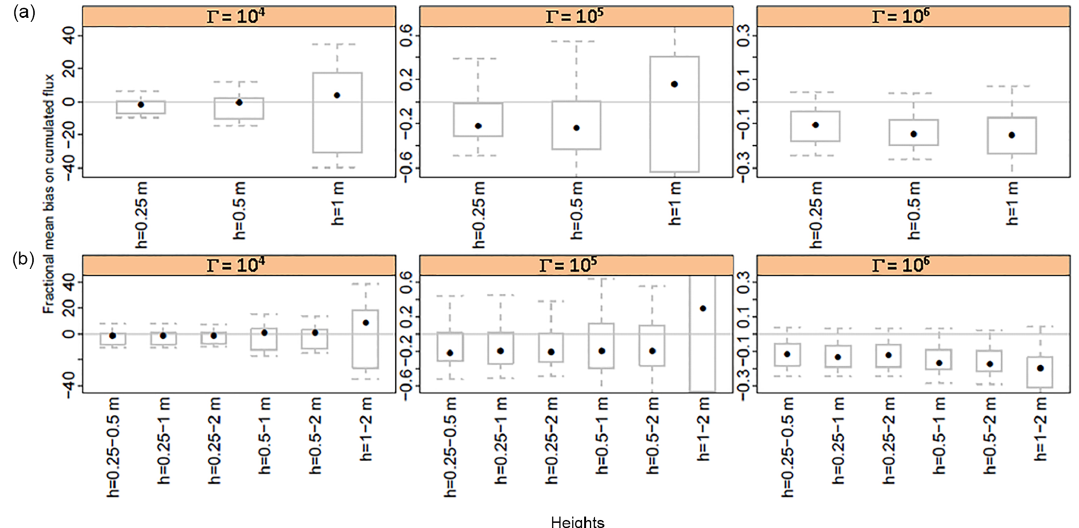
Figure 10. Effect of target heights on source inference in a multiple-plot set-up for integration periods of 1 week (168h). Same as the case reported for Fig. 9 except that strategies C1 (with a single sensor, top graphs) and C3 (with two heights, bottom graphs) are compared here (the background is assumed known in both